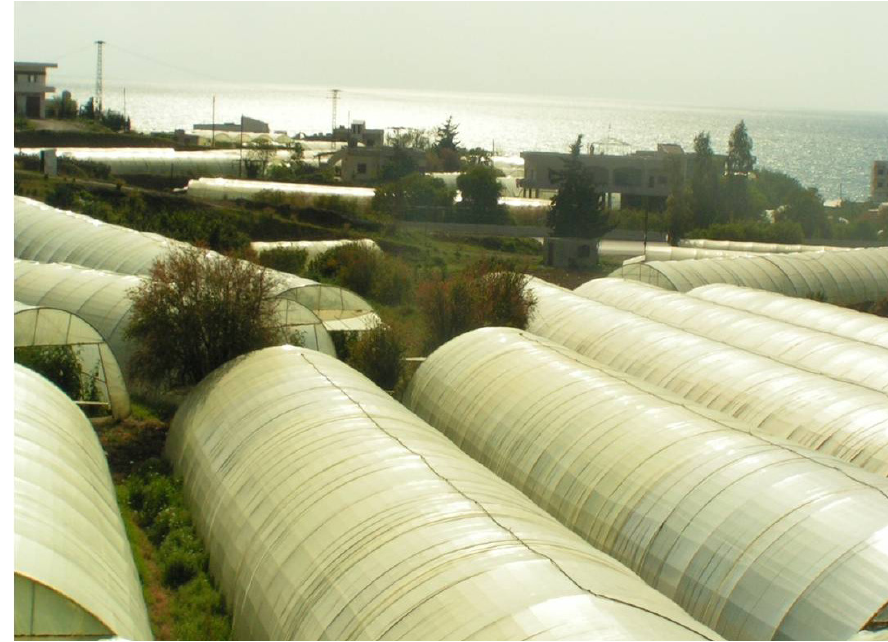
Figure 1. Intensive greenhouse tomato cultivation in the coastal Mediterranean provinces of